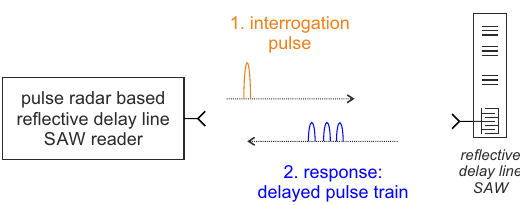
Figure 7. Schematic drawing of a reflective delay line SAW interrogation with a pulse radar based SAW